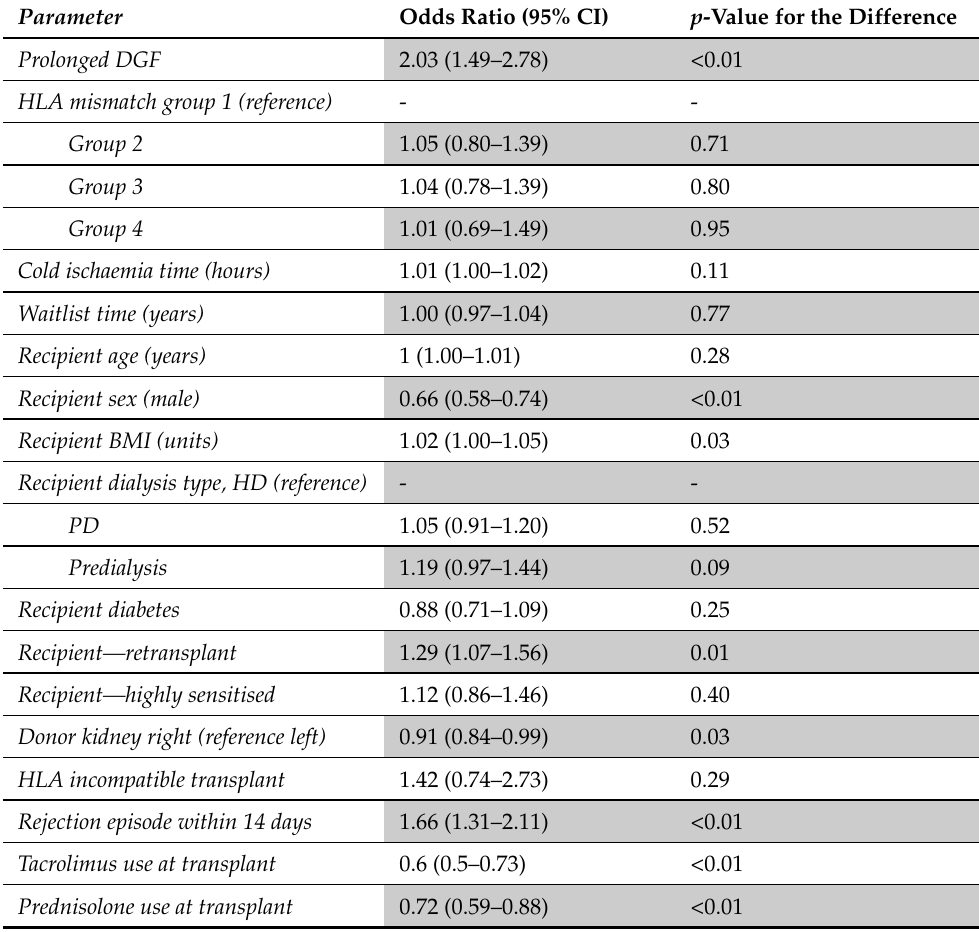
Table 4. Multivariate analysis—Odds of poor 12-month function.